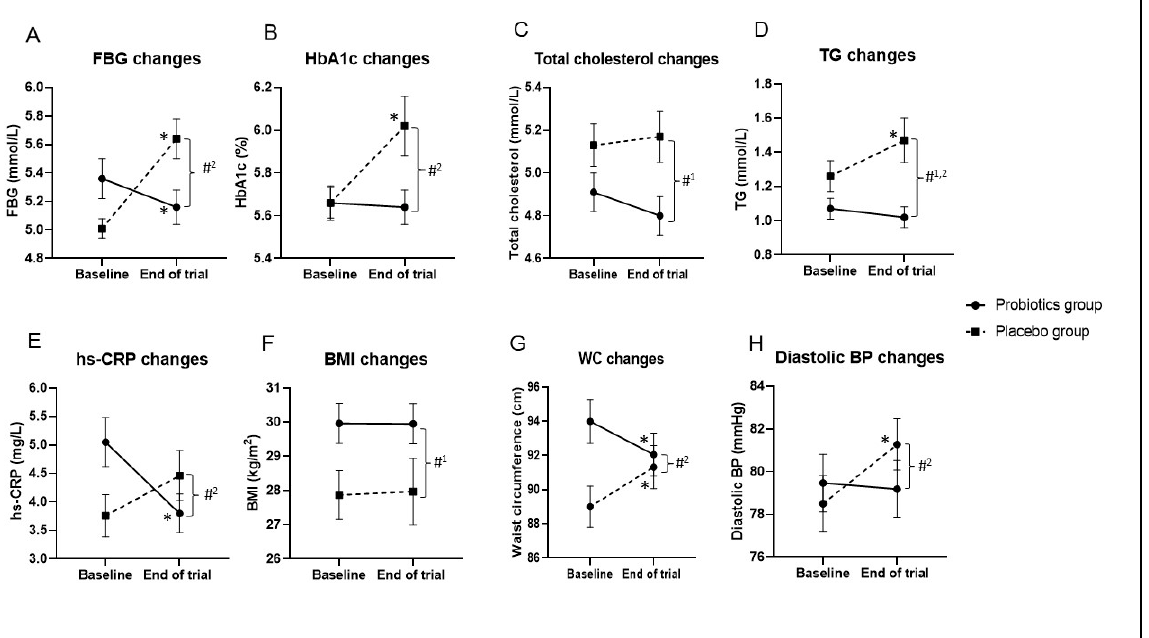
Figure 2. Changes in biochemical and anthropometric outcomes during 12-week intervention. Data are presented as mean ± standard error of the mean. ( A ) Fasting blood glucose (FBG) changes, ( B ) HbA1c changes, ( C ) total cholesterol changes, ( D ) triglyceride (TG) changes, ( E ) high-sensitivity C-reactive protein (hs-CRP) changes, ( F ) body mass index (BMI) changes, ( G ) waist circumference (WC) changes, ( H ) diastolic blood pressure (BP) changes. p -value < 0.05 was considered statistically significant. * Significant difference within the group. * p -value < 0.05, ** p -value < 0.01, and *** p -value < 0.001 were considered statistically significant. # 1 Significant difference between the two groups based on repeated-measures analysis of variance (ANOVA). # 2 Significant interaction between the outcome and intervention group.